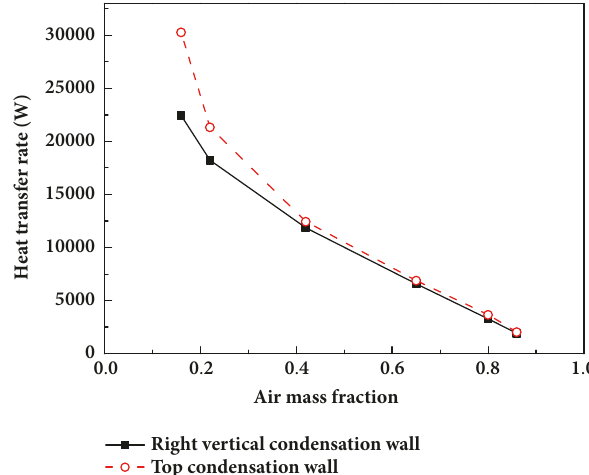
Figure 12: Velocity contour and streamlines in the AP1000 contain- ment.